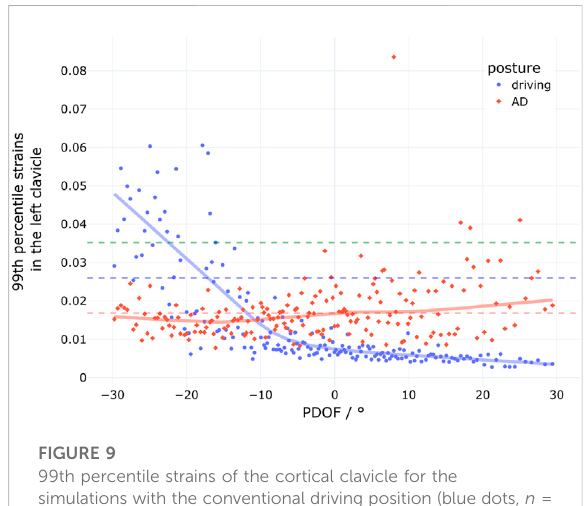
FIGURE 9 99th percentile strains of the cortical clavicle for the simulations with the conventional driving position (blue dots, n = 185) and the simulations with the rearward adjusted seat (AD, red diamonds, n = 185). The three dashed lines indicate the fracture thresholds for the three age